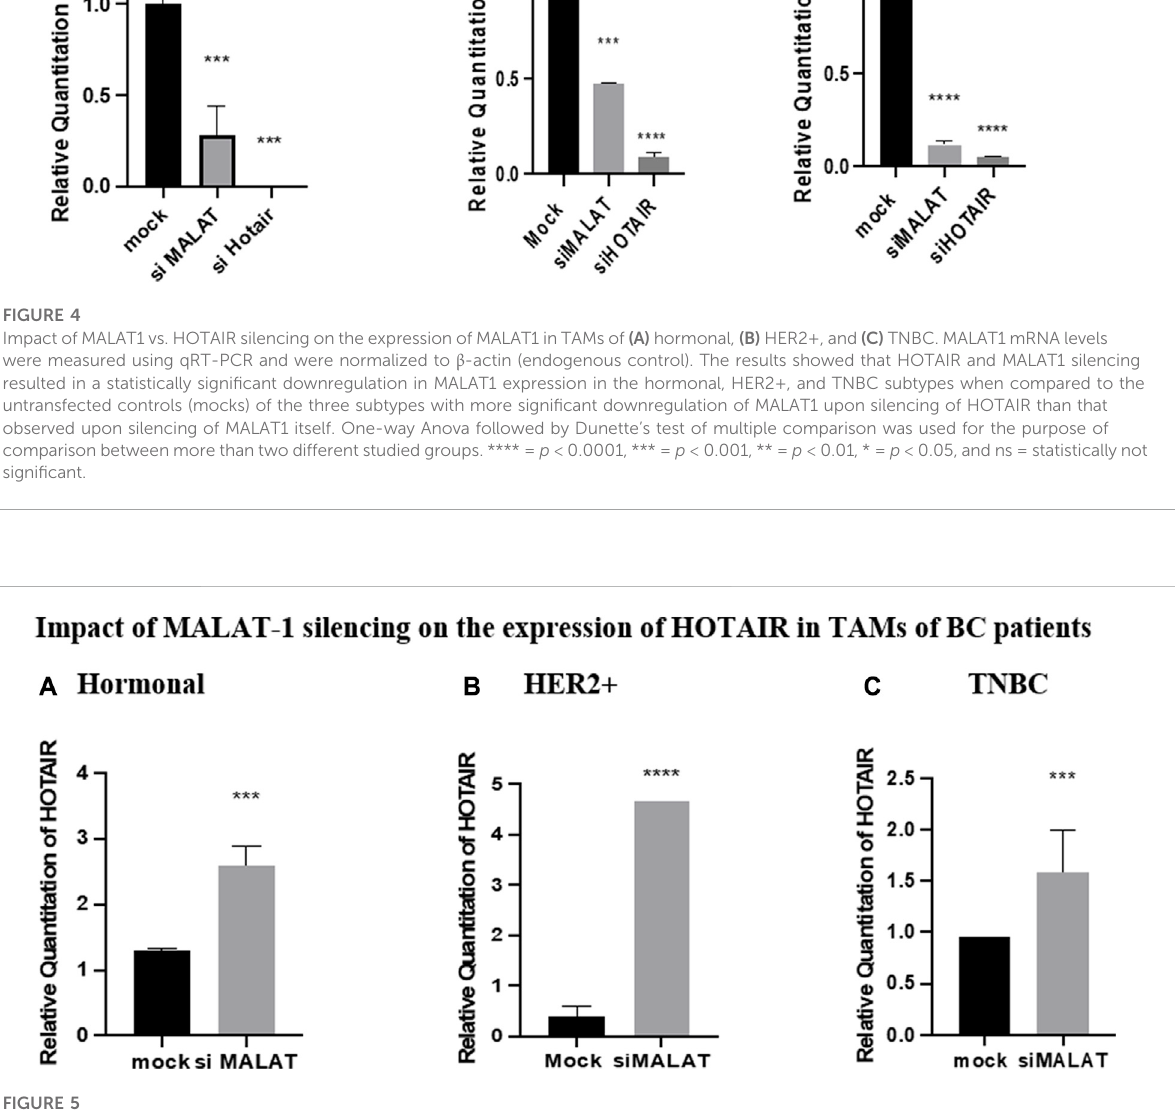
Frontiers in Molecular